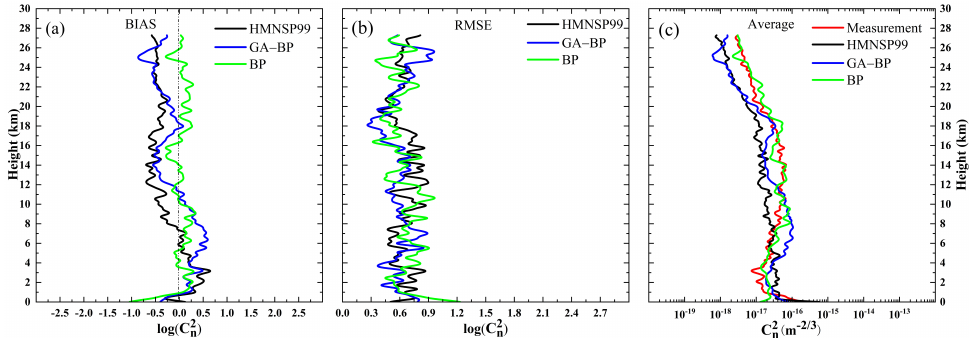
Figure 9. Statistical results of the C 2 n ( h ) profiles between the GA-BP, BP and HMNSP99 models in the